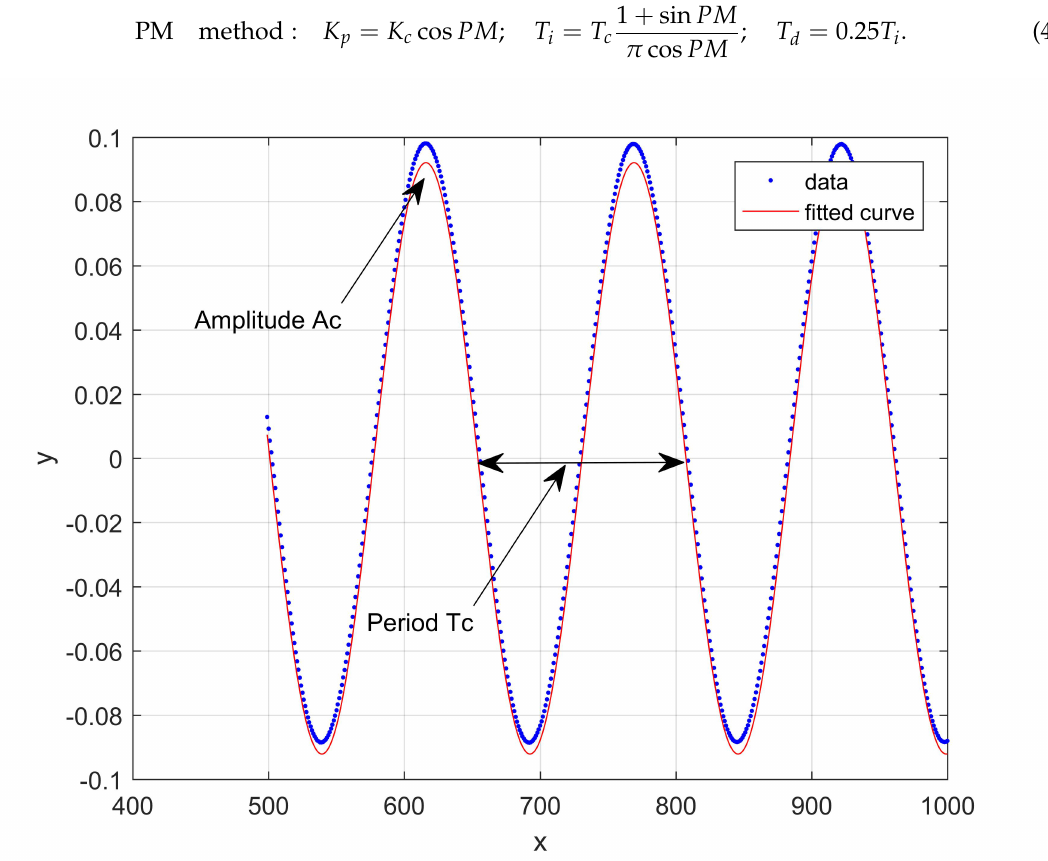
Figure 5. Typical result of the relay test.